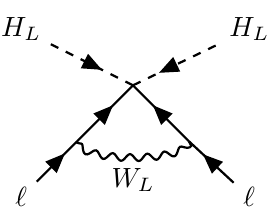
Figure 12 . A diagram contributing to a non-zero neutrino mass for the case with tree-level cancellation between m (5) and m ( ss )